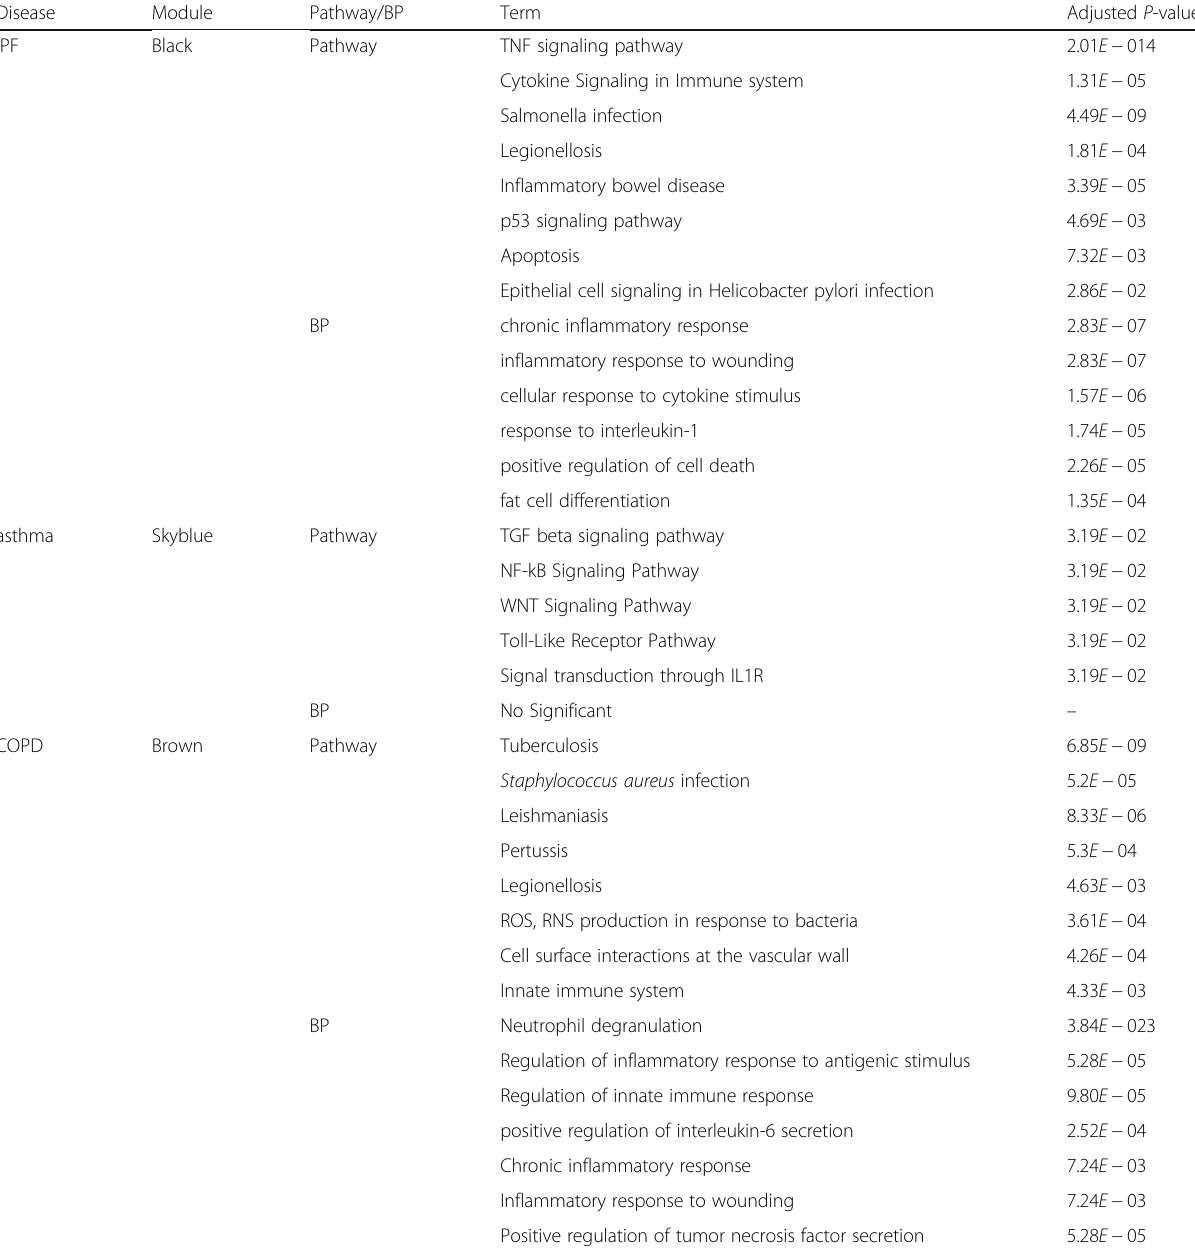
Table 5 Results of the Pathway and GO Biological Process Enrichment Analysis for Several Important Modules